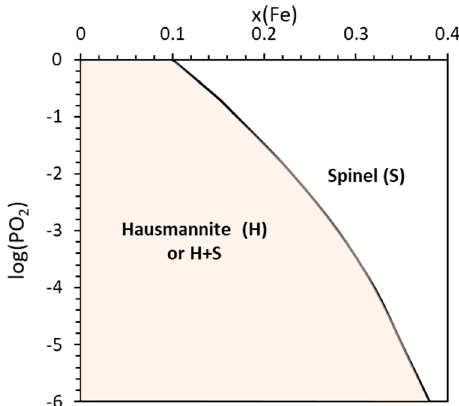
Figure 9. Calculated minimal amount of Fe in the Mn-Fe-O system in order to avoid the formation of the hausmannite phase at any temperature (model from [47]).